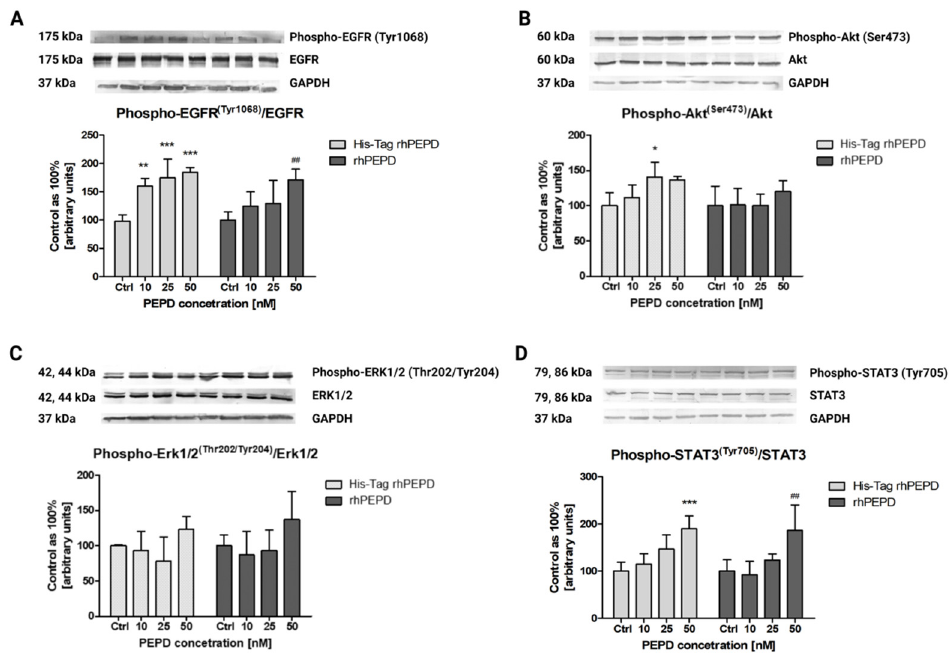
Figure 7. Phosphorylation of the selected EGFR-downstream signaling proteins such as ( A ) EGFR; ( B ) Akt; ( C ) ERK1/2; ( D ) STAT3 upon 30 min treatment with His-TagrhPEPD or rhPEPD. The ratio presents the level of phospho-protein to total protein expression. Statistical significances were expressed using symbols such as * < 0.05; ** < 0.01; *** < 0.001; ## < 0.01 (* vs. His-Tag rhPEPD control).